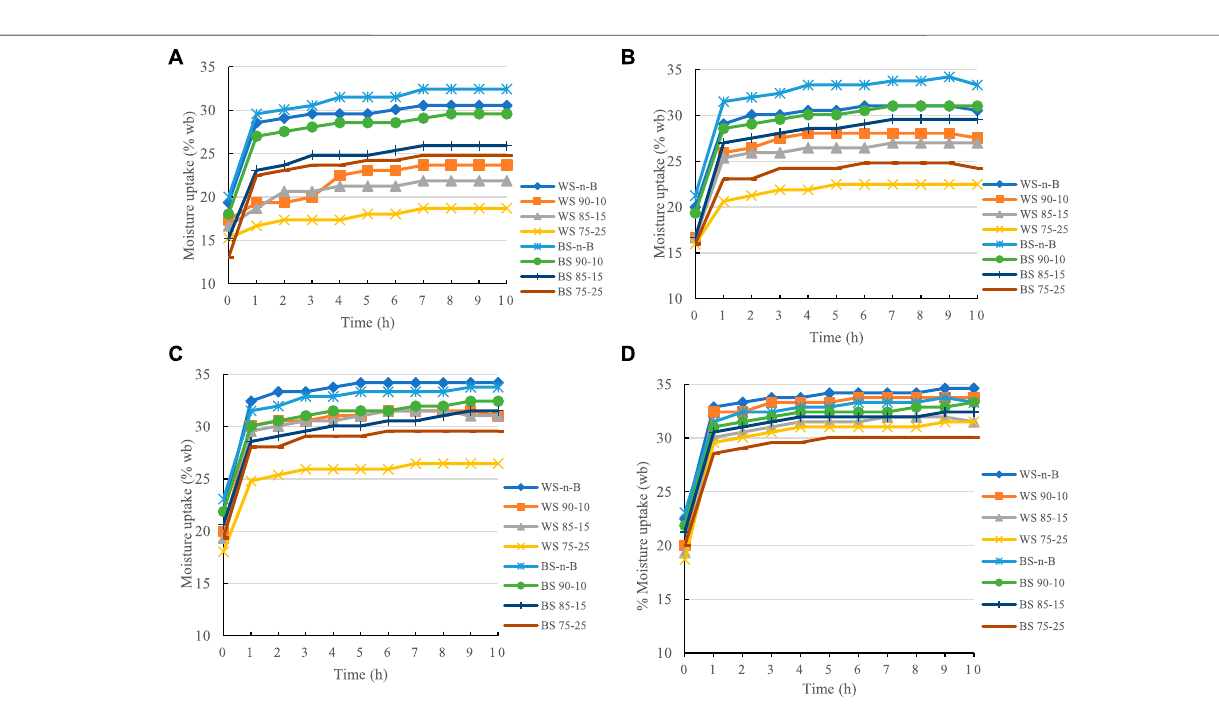
Frontiers in Energy Research |